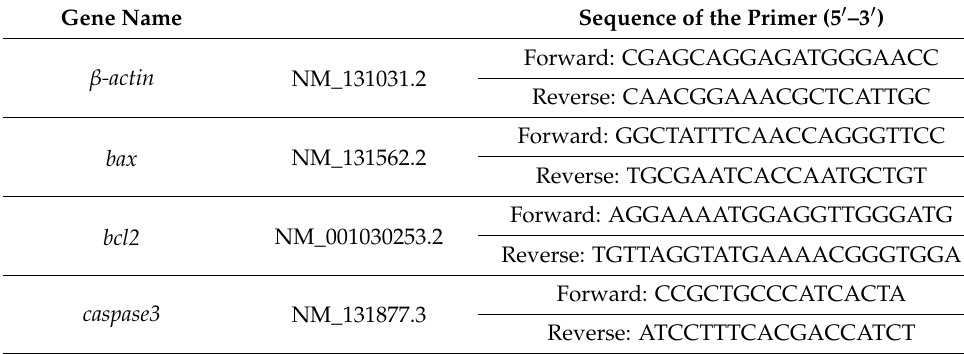
Table 1. Sequences of primers for the genes